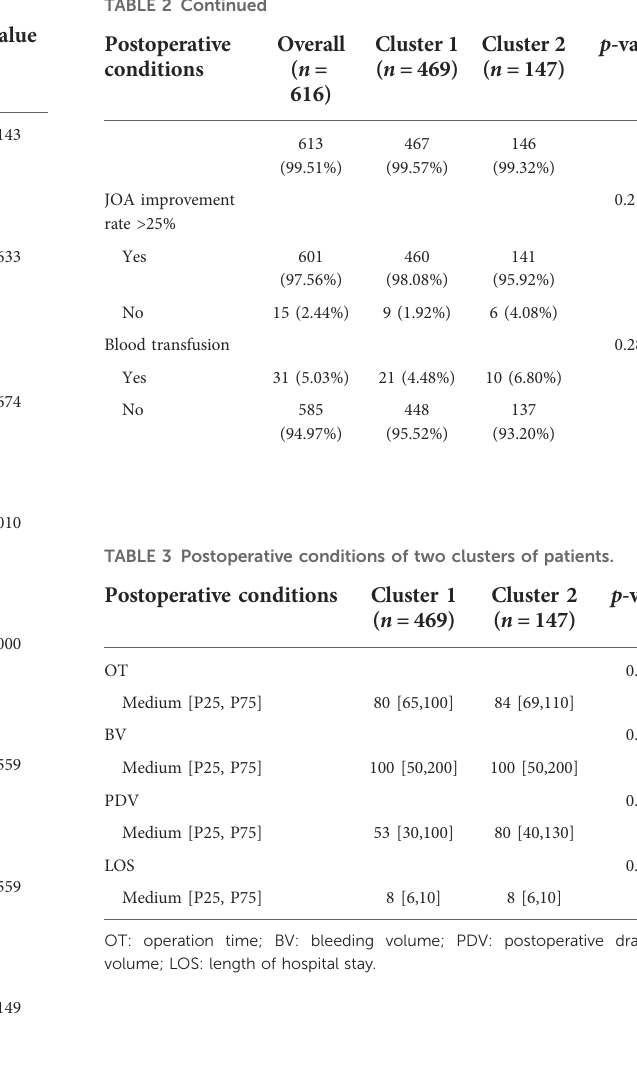
TABLE 2 Postoperative conditions of two clusters of patients.